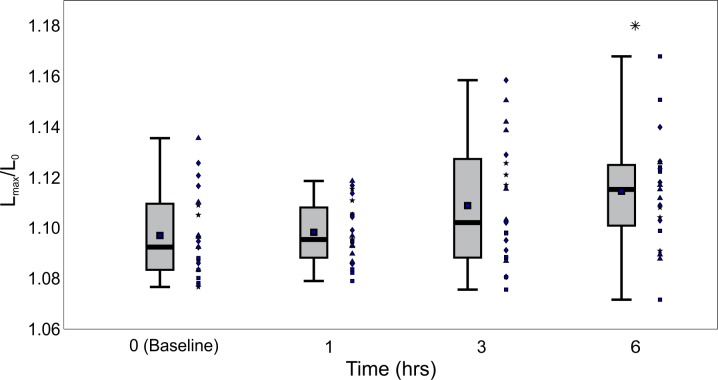
Effect of participant on maximum stretching ratio observed at different times postprandial.The top and bottom of the lightly shaded rectangles indicate the 25th and 75th quartiles, respectively, the thick black bars indicate the median, the dark square markers indicate the mean, and the whiskers represent the maximum and minimum values observed. Each marker shape corresponds to a particular participant; repeated markers denote trial replicates with blood drawn from that same individual. The total number of cells observed: n0HR = 1955, n1HR = 1870, n3HR = 1450, and n6HR = 1393. Asterisk (*) indicates p<0.05.